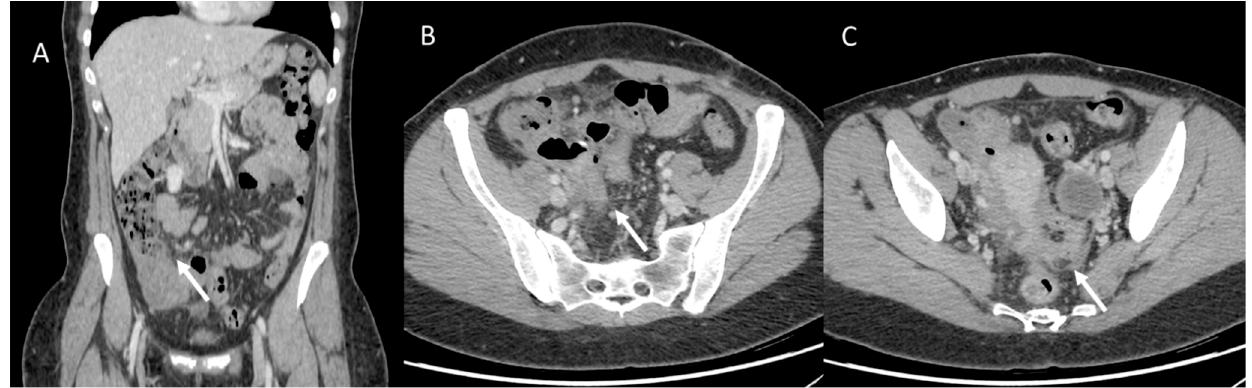
Figure 6. Woman with operated appendiceal tumor (( A ): in coronal plane, arrow). CT assessment of peritoneal carcinomatosis (( B,C ), arrow).